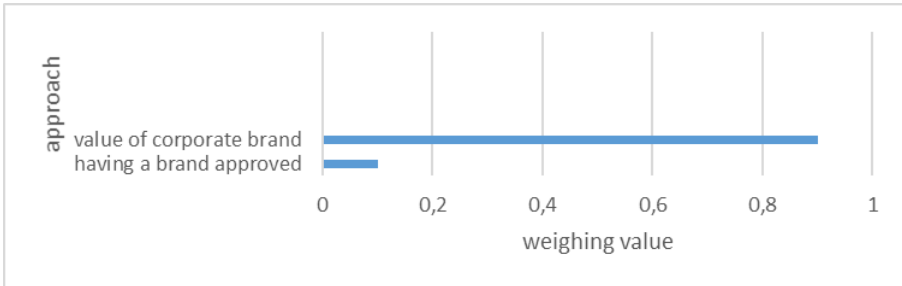
Figure 14: Result of brand sub criteria weighing value (Inconsistency